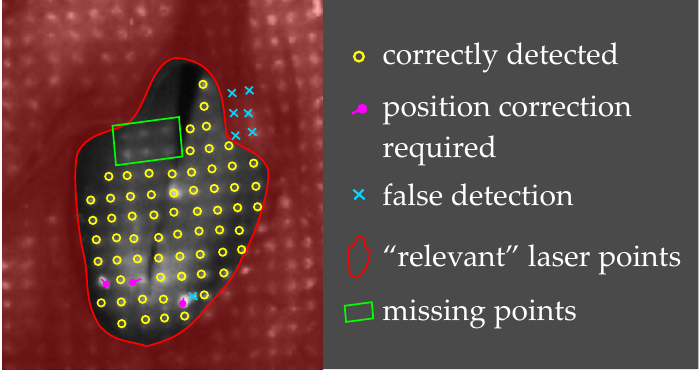
Figure 13. Classification scheme for the evaluation of initial grid detection